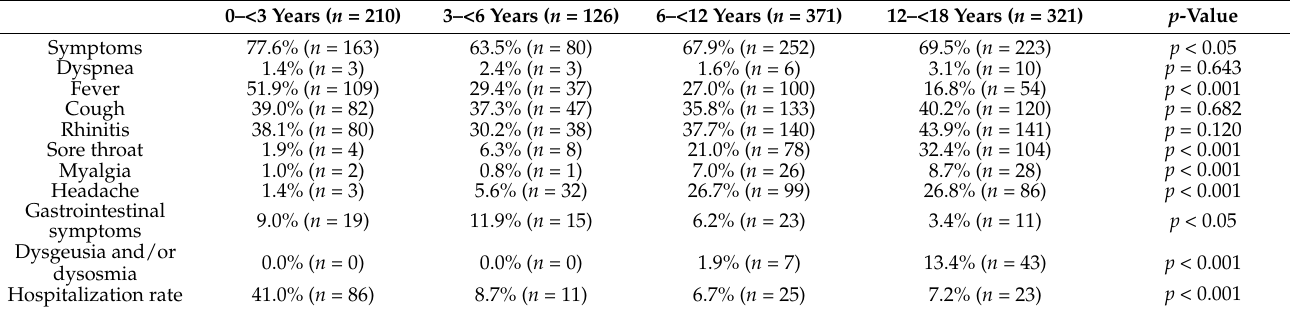
Table 4. Comparison of different age groups with regard to symptoms of patients who tested positive for SARS-CoV-2 ( n =